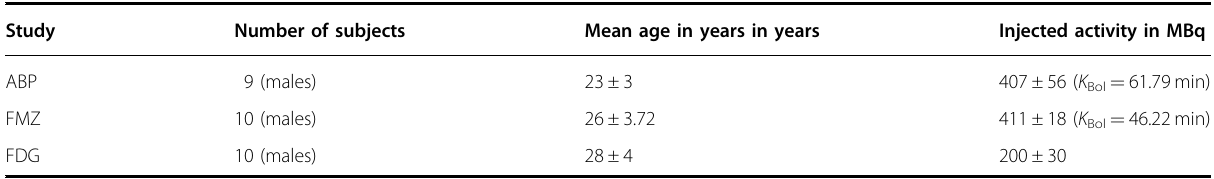
Table 1 Subject and injected activity details for each